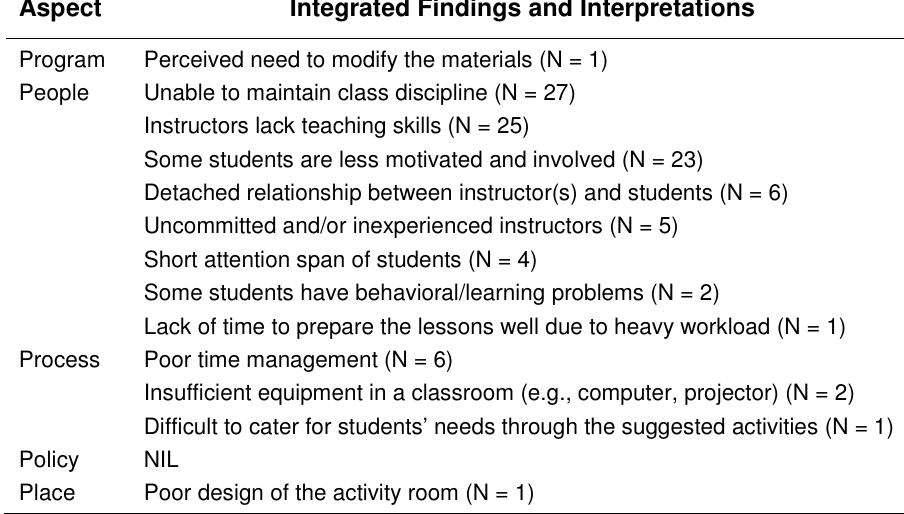
Obstacles Impeding the Quality of Program Implementation Integrated Findings and